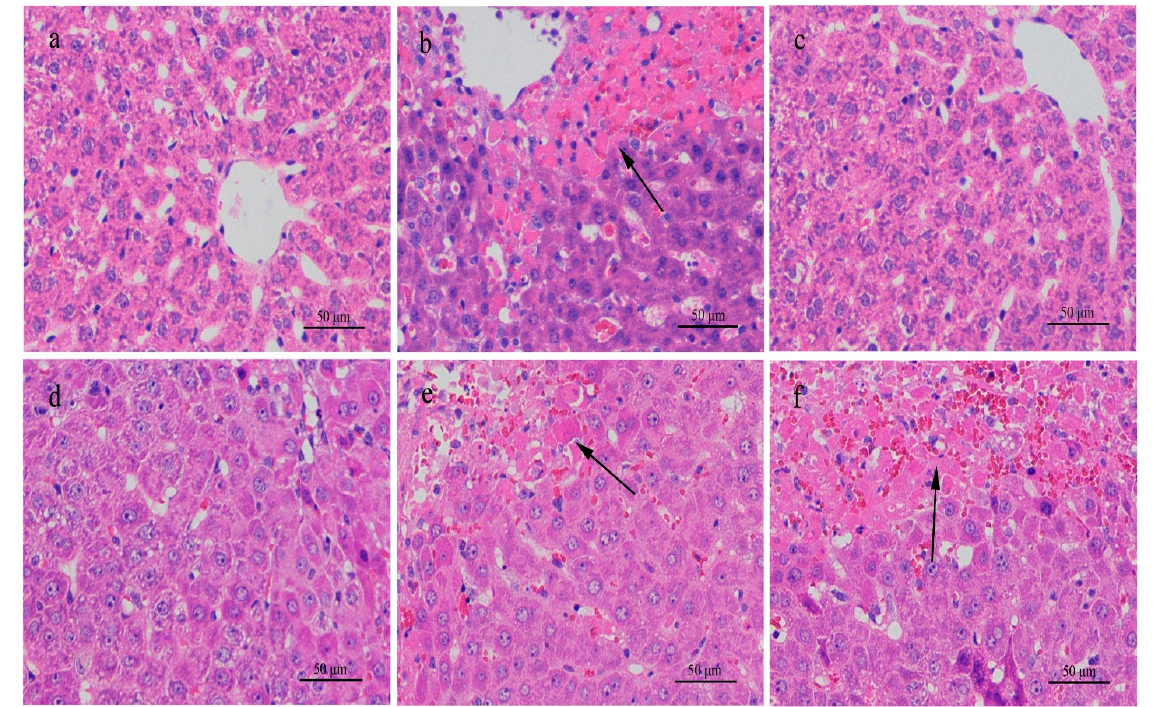
Figure 3. H & E stained histological sections of the livers of rats exposed to different concentrations of MC-RR for 24 h. ( a ) 0.0 μ g/kg MC-RR. ( b ) 574.7 μ g/kg MC-RR. ( c ) 287.3 μ g/kg MC-RR. ( d ). 50.0 mg/kg DXM mixed with 574.7 μ g/kg MC-RR. ( e ) 10.0 mg/kg DXM mixed with 574.7 μ g/kg MC-RR. ( f ) 2.0 mg/kg DXM mixed with 574.7 μ g/kg MC-RR. Note necrosis areas in Figures 3b, 3e, and 3f (arrows).